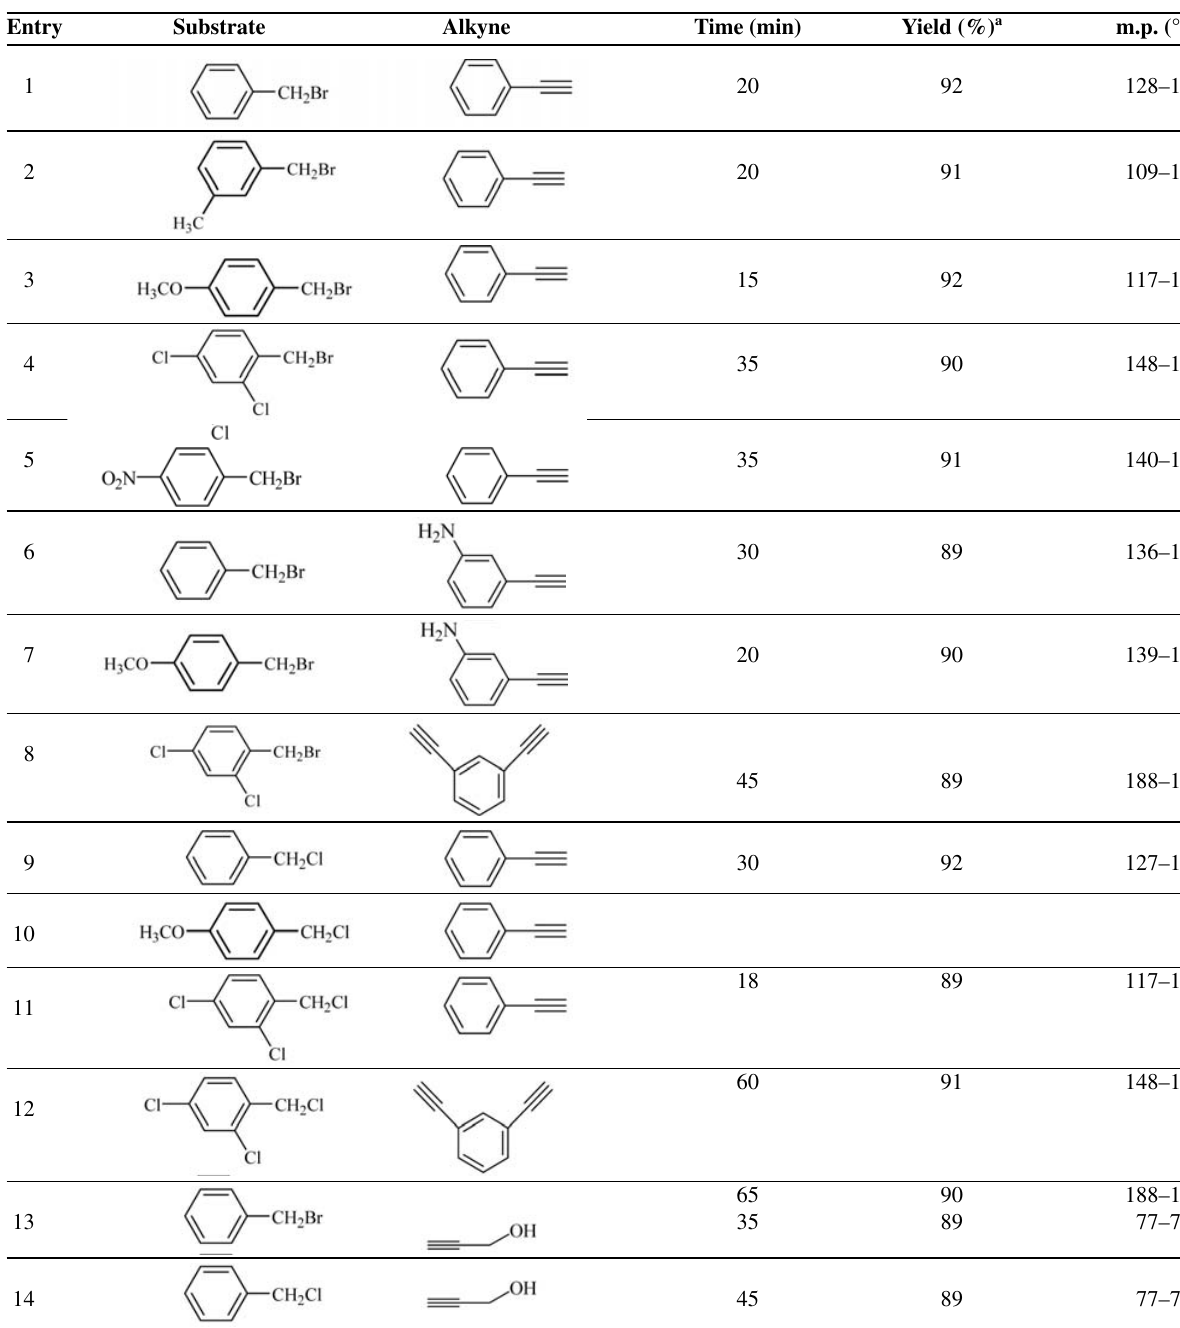
Table 4. Synthesis of 1,2,3- triazoles catalyzed by